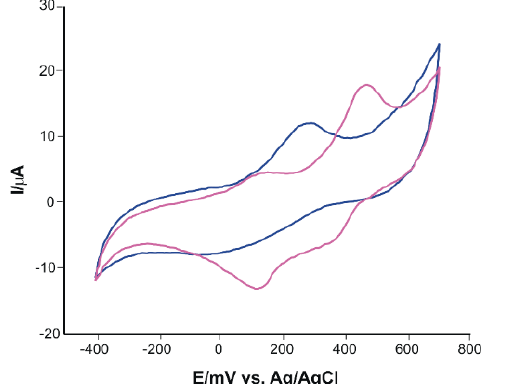
Figure 5. Cyclic voltammograms of SPCE-CNT immersed in Tanakan solution (purple line) and GinkoPrim Max (blue line).